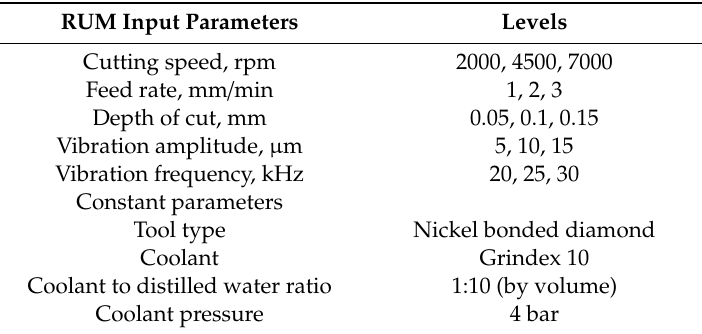
Table 2. Input parameters of RUM and their